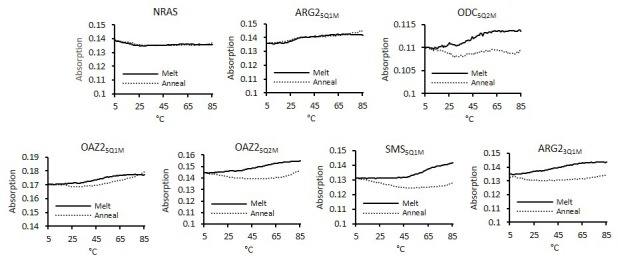
UV melt-anneal profiles for mutant G2-PQS's.UV melt-anneal profiles for NRASM, ARG25Q1M, ODC5Q2M, OAZ25Q1M, OAZ25Q2M, SMS5Q1M and ARG23Q1M at 295 nm (performed in the presence of 100 mM K+, UV performed in 1 mM K+ for NRAS). Two replicates of each biophysical experiment were performed. NRAS: UGUGGGAGGGGCGGGUCUGGG. NRASM: UGUAAAAGGGGCGGGUCUGGG.